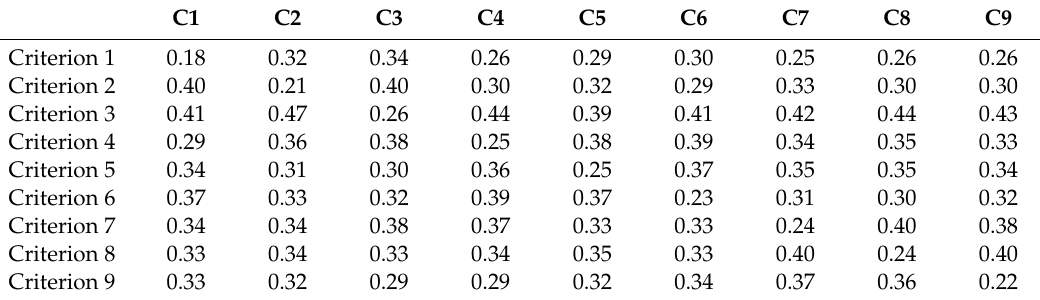
Table 6. Unweighted supermatrix for the criteria.